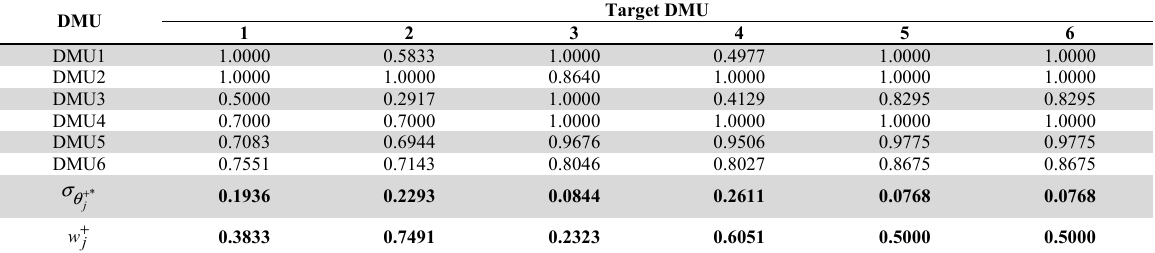
Ideal CEM of six nursing homes